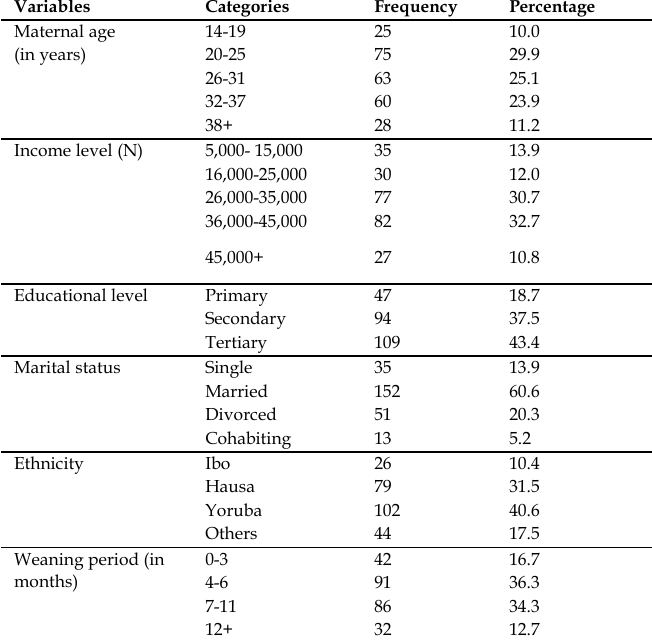
Table 1: Distribution of socio-demographic characteristics of the respondents (N =